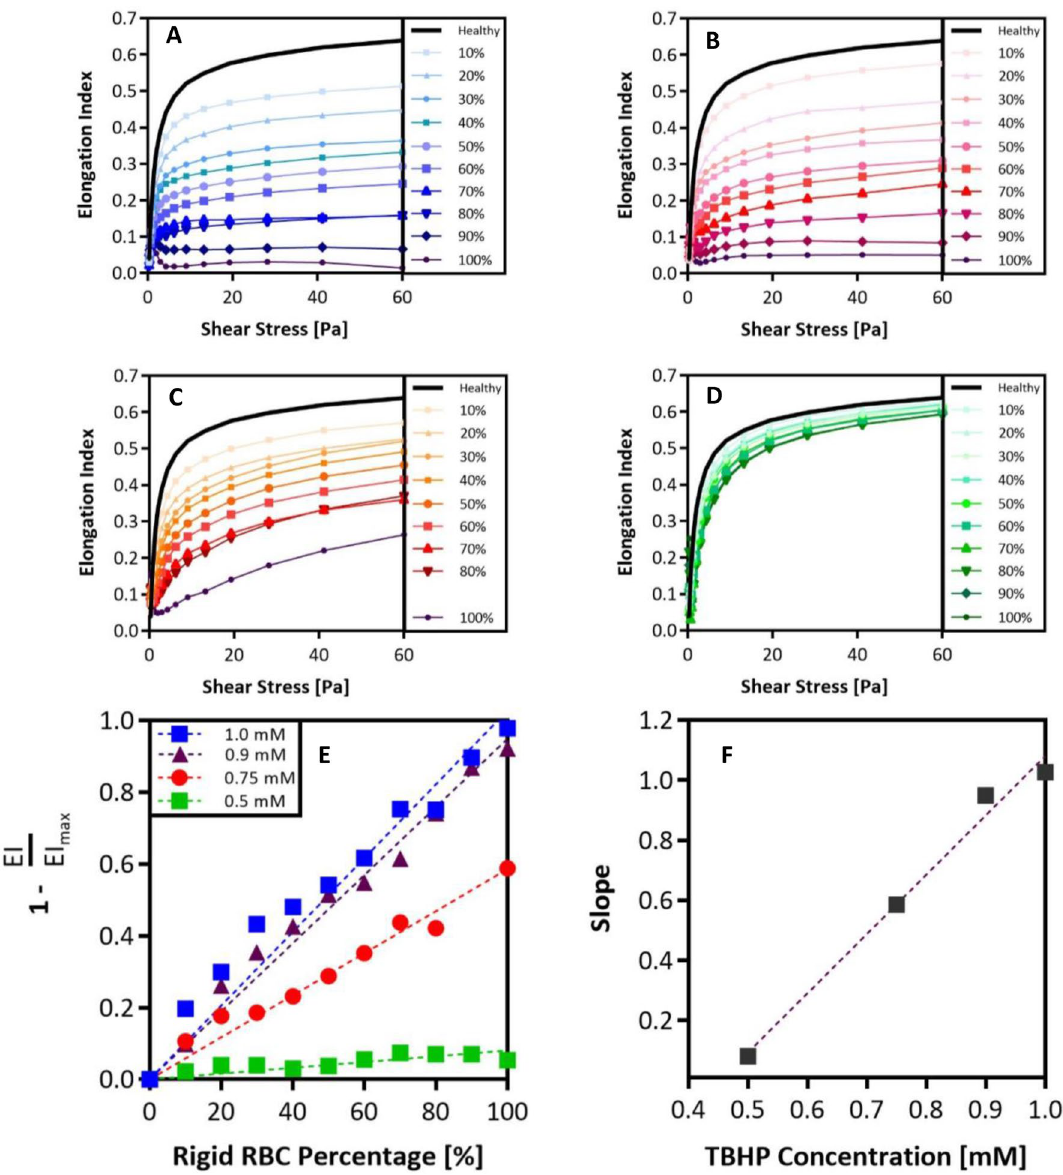
Figure 1. Ektacytometry analysis of various rigid RBC populations with varying RBC membrane stiffnesses. Ektacytometry curves for various rigid-to-healthy fractions ranging from 0 to 100% in increments of 10% rigid RBCs present. Rigid RBCs have been treated with: ( A ) 1.0 mM. ( B ) 0.9 mM. ( C ) 0.75 mM. ( D ) 0.5 mM TBHP. ( E ) Maximum EI recorded at 60 Pa for each rigid fraction condition is compared to EI max of the healthy condition, these ratios are plotted as a function of rigid RBC fraction present. Linear regression is used to determine the slope of these rigid-to-healthy ratio trends. ( F ) Slopes of rigid-to-healthy ratio trends are plotted as a function of TBHP